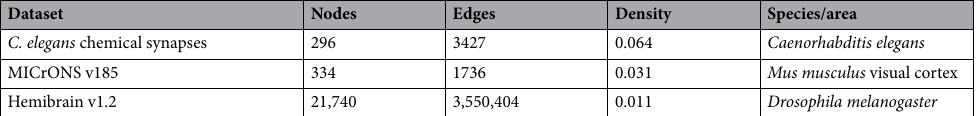
Table 1. Connectome graphs reviewed in this work. The C. elegans connectome was derived from the July 2020 C. elegans adjacency matrix at WormWiring.org , and synapses were filtered to only include chemical synapses for this analysis 24,25 . The MICrONS v185 graph was derived from the proofread soma subgraph at microns-explorer.org 10,26 . The Hemibrain v1.2 dataset was accessed through the neuPrint system 6